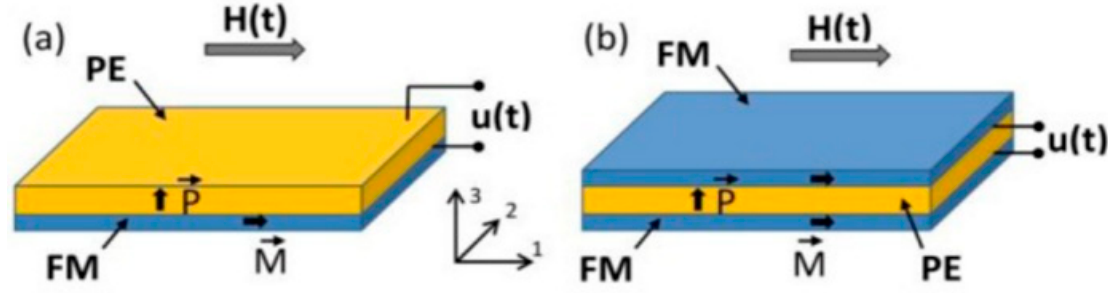
Figure 1. Geometry of a ( a ) bilayer MP and ( b ) three-layer sandwich-like (L-T type) MPM structures. u(t) is the alternating induced ME voltage. Figure taken with permission from [16].